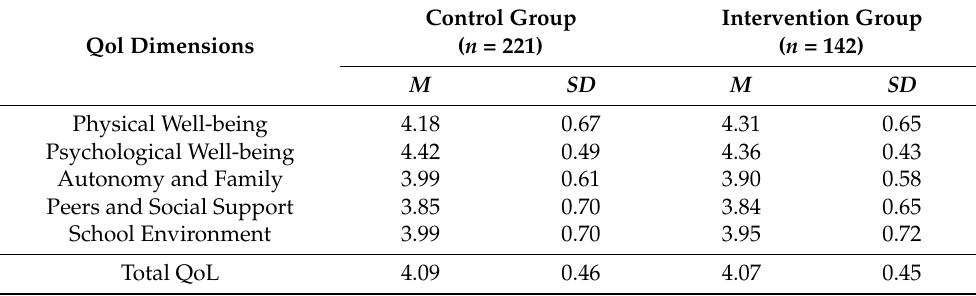
Table 4. Descriptive of QoL in control and intervention